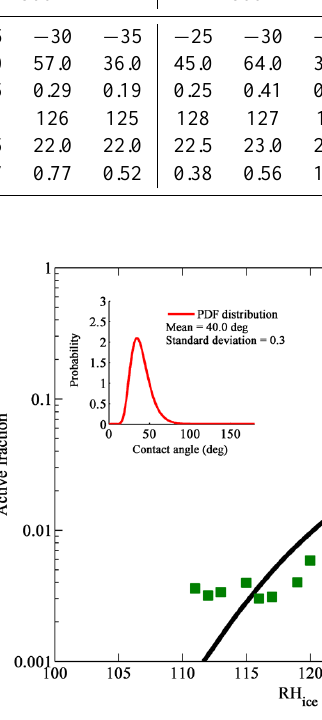
Fig. 2. Active fraction ( F ice ) of ATD particles, at − 35 ◦ C and 400 nm in diameter (Table 2), is given as a function RH ice . The solid curve shows the PDF model fit to the experimental data points. The inset shows the PDF distribution with corresponding parameters. The error for RH ice is approximately ±3 %.